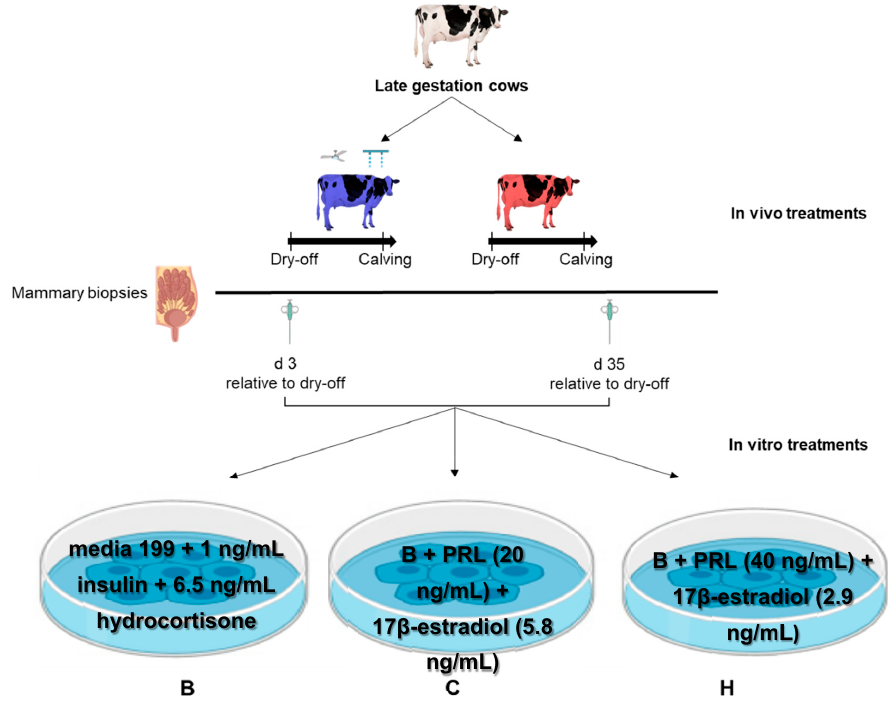
Figure 1. Schematic representation of the experimental design presented in the current study. Late gestation cows were dried off at 46 d before calving and assigned to 1 of 2 in vivo treatments: cooling (CL) ( n = 7); provided shade of the barn and active cooling by soakers and fans (blue); heat treatment (HT) ( n = 7); only provided shade of the barn (red). Mammary biopsies were collected at 3 d (to capture the involution phase) and 35 (to capture the mammary redevelopment phase) and tissue explants were incubated in 1 of 3 in vitro treatments: (1) Basal ( B ): no prolactin or oestrogen; (2) CL-mimic ( C ): B + 20 ng/mL prolactin + 5.8 ng/mL oestrogen or (3) HT-mimic ( H ): B + 40 ng/mL prolactin + 2.9 ng/mL